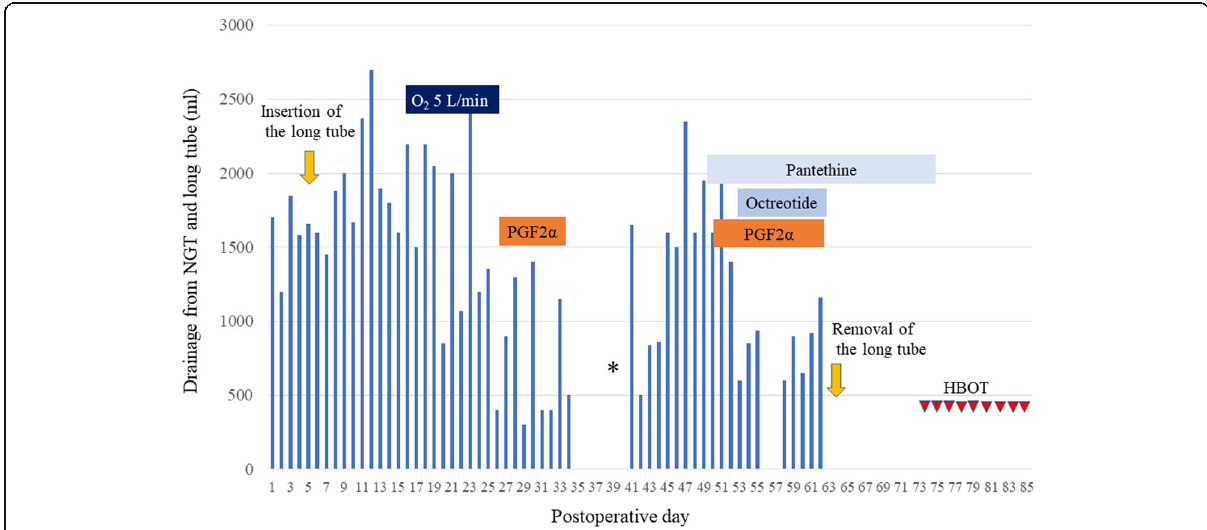
Fig. 4 Long tube drainage and treatment course. High output discharge from a nasogastric tube (NGT) or a long tube continued despite oxygen insufflation. The days with no data on the amount of drainage are days when the long tube was temporarily clamped or removed. HBOT hyperbaric oxygen therapy, PGF2 α prostaglandin F2 α . An asterisk shows the day of the second laparotomy and triangles indicate the days when the